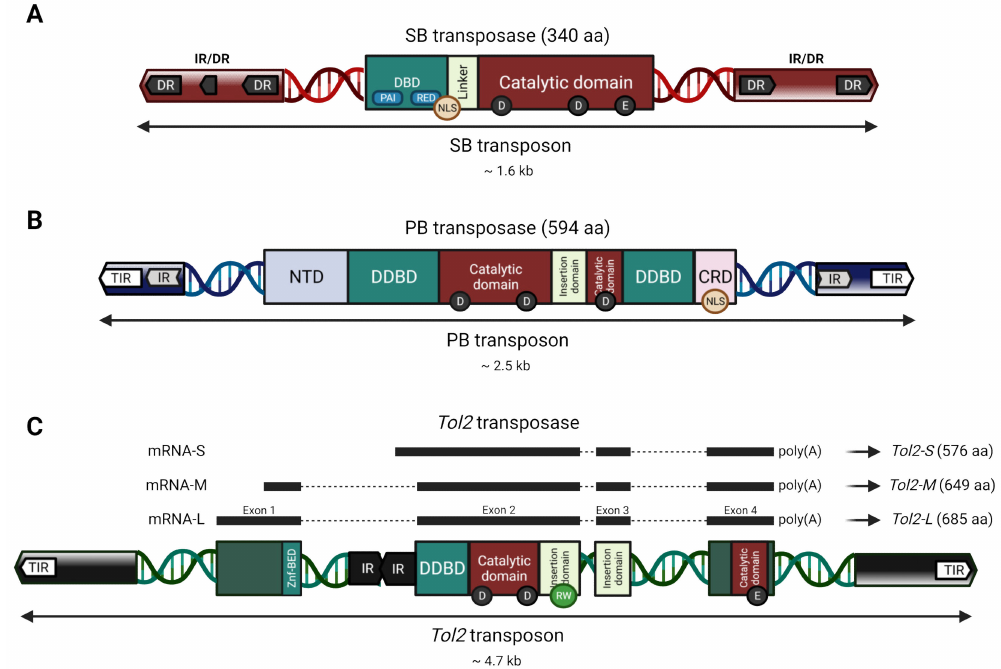
Figure 2. Organization and functional domains of the Sleeping Beauty (SB), piggyBac (PB), and Tol2 autonomous transposable elements and transposases. Transposons are depicted as a double-stranded DNA helix flanked by TIRs (arrows). Trans- posases within each autonomous transposon appear with their respective protein domains (rectangles) after transcription and translation. ( A ) The SB transposon is flanked by TIRs in an inverted repeat/direct repeat (IR/DR) structure (dark grey and red arrows). The SB transposase is depicted with its domains, including a nuclear localization signal (NLS, orange circle), and the PAI and RED subdomains (blue rounded rectangles) of the DNA binding domain (DBD, green rectangle). ( B ) The PB transposon is flanked by its TIRs and subterminal IRs (white, blue and light grey arrows). The PB transposase is shown with its domains and NLS (orange circle). ( C ) The Tol2 transposon is flanked by its TIRs and subterminal regions (white and black arrows). The autonomous Tol2 transposon contains an internal Angel element (IR black arrows) and the Tol2 transposase coding sequence with its four exons coding for different protein isoforms (black bars). Tol2 is shown with its domains, as well as the typical RW-motif (light green circle) of the members of the hAT family. The structure of Tol2 ’s putative functional domains was matched with the coding sequence based on the general domains of the hAT family members [28], the nucleotide positions on the Tol2 DNA sequence (DDBJ/EMBL/GenBank accession no. D84375), and previous analysis of Tol2 [29–31]. NTD: N-terminal domain; CRD: Cysteine-rich domain; DDBD: Dimerization and DNA-binding domain; Znf-BED: BED-type zinc finger